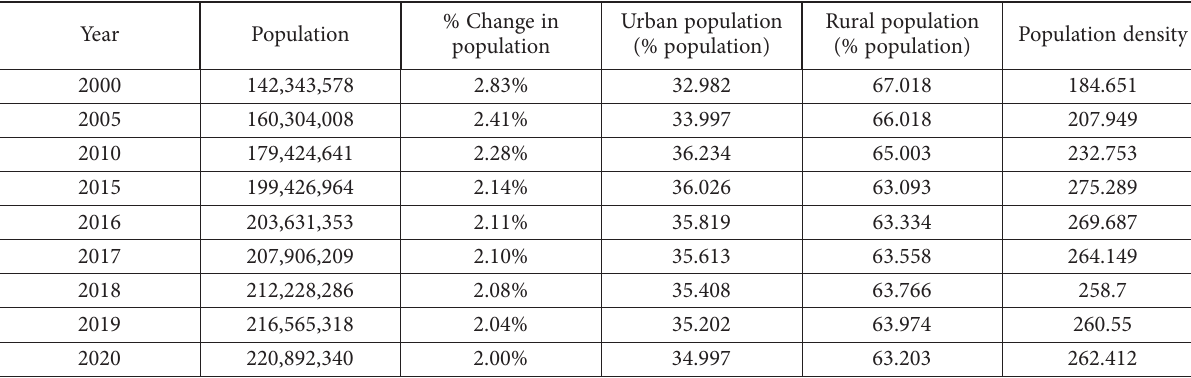
Table 1. Growth in demand for residential properties due to urbanization and growth in population (source: The World Bank, 2019b)